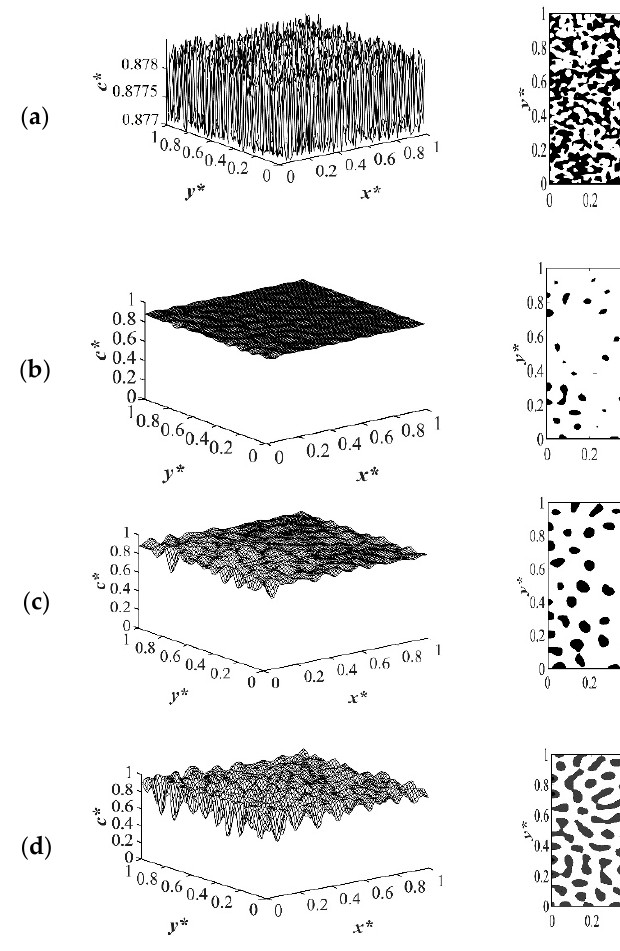
Figure 10. Spatial concentration ( left column), phase separated pattern ( middle column) and tem- perature ( right column) profiles for off-critical quench without considering enthalpy of demixing c *